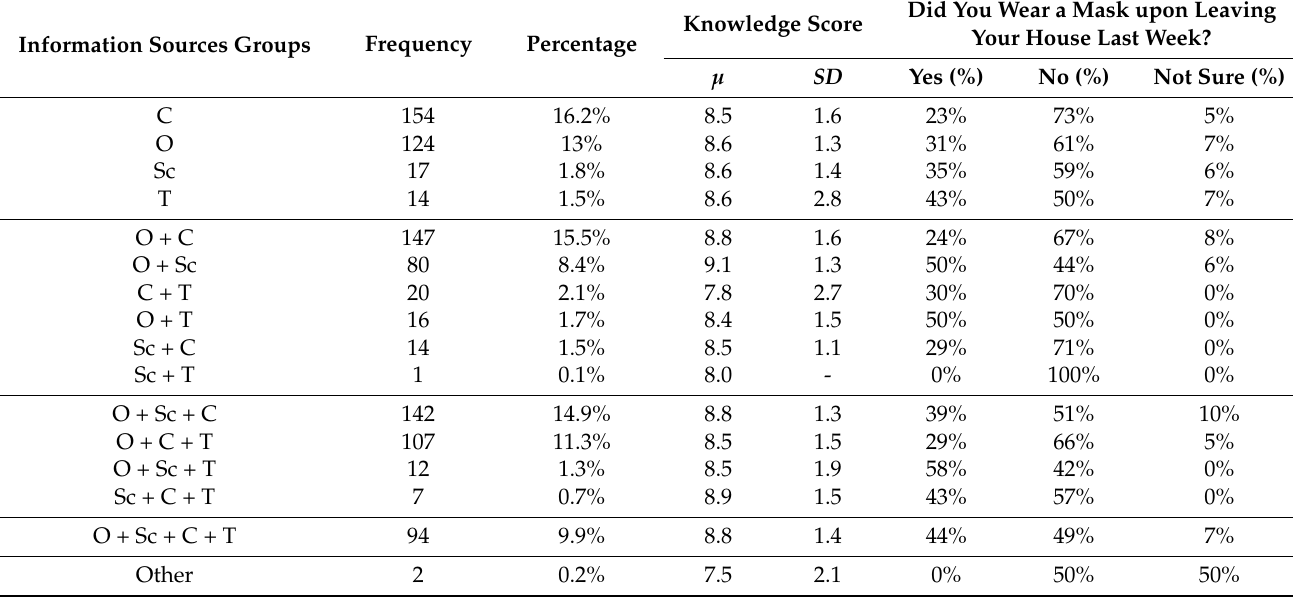
Information Sources